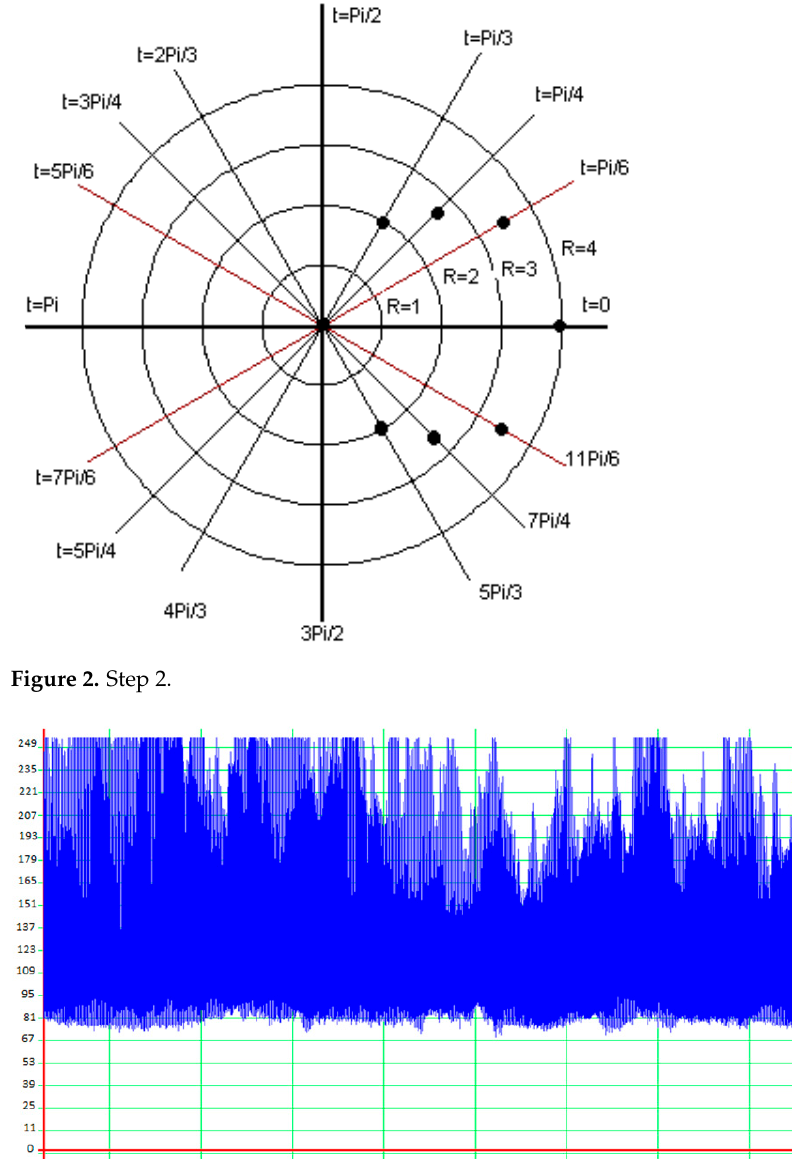
Figure 1. Step 1. Network with different weight (1–4).